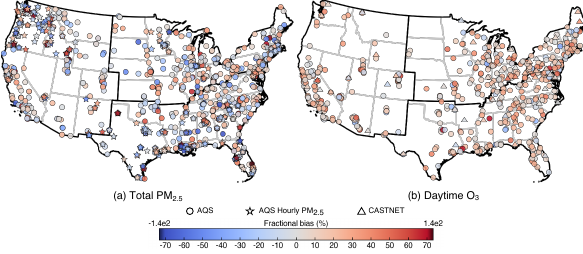
Figure 2. AQS, AQS hourly, and CASTNET monitor locations and annual average fractional bias for (a) total PM 2 . 5 and (b) daytime average O 3 concentrations. Corresponding information for other pollutants and variables is in Fig.